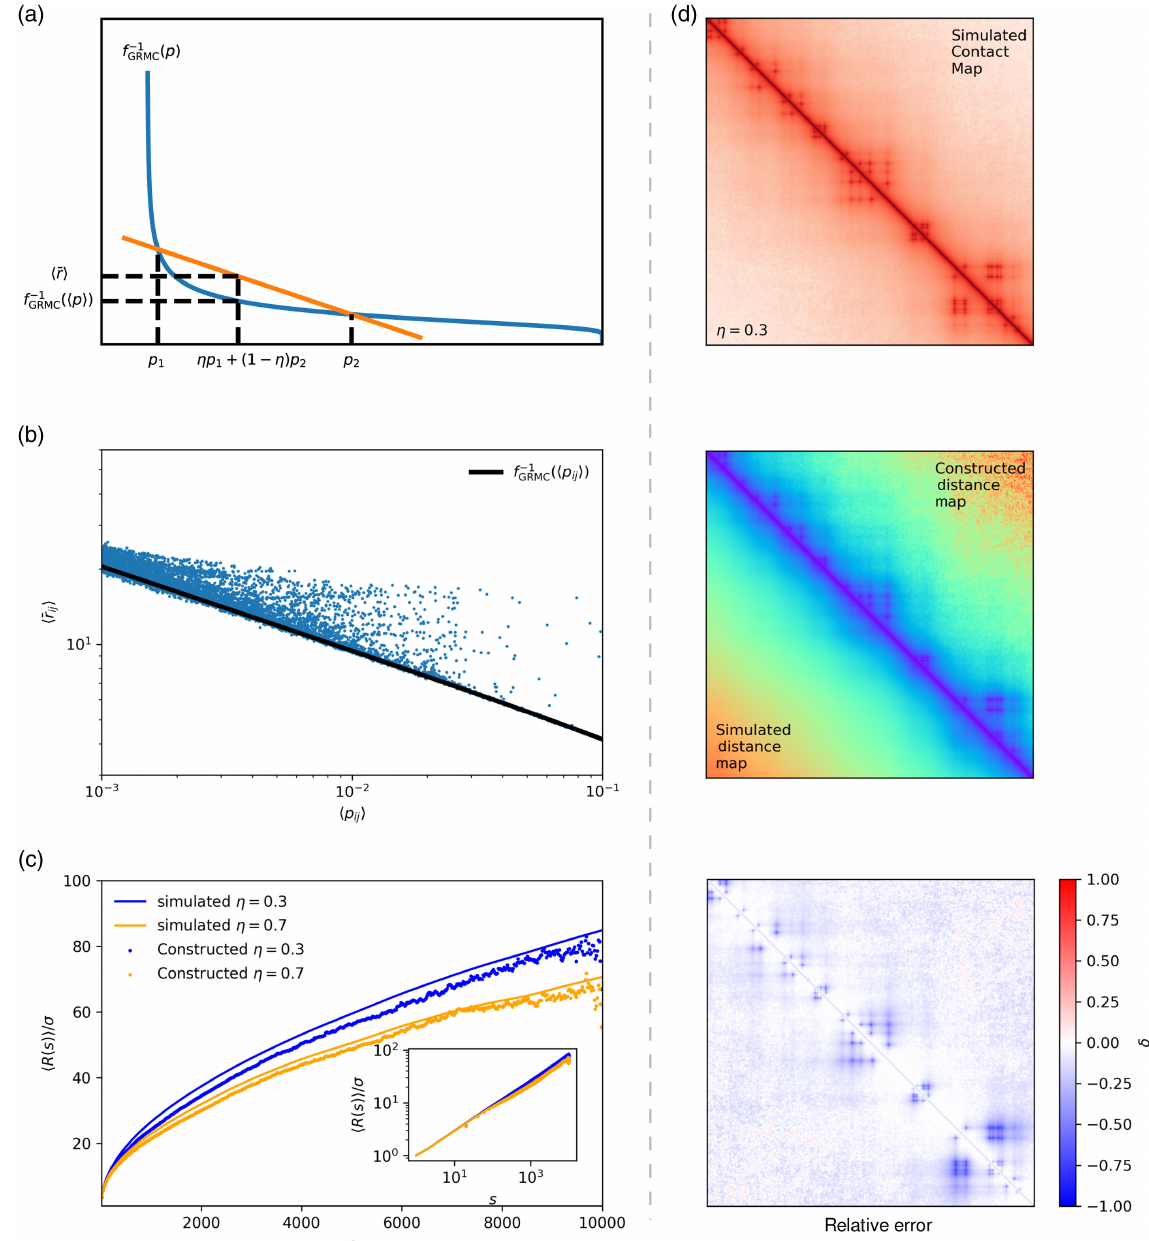
FIG. 2. (a) Lower bound for the mean spatial distance h ¯ r i illustrated graphically. The blue curve is the function f − 1 which exists GRMC since f is a monotonic function. The orange line is the secant line between the points [ p 1 ; f − 1 ð p 1 Þ ] and [ p 2 ; f − 1 ð p 2 Þ ]. All the GRMC GRMC GRMC points between p 1 and p 2 on the x axis can be expressed as η p 1 þ ð 1 − η Þ p 2 ≡ h p i for some value of η ∈ ½ 0 ; 1 (cid:2) . The y -axis value corresponding to h p i is η f − 1 ð p 1 Þ þ ð 1 − η Þ f − 1 ð p 2 Þ ≡ h ¯ r i and f − 1 ðh p iÞ for the orange line and blue curve, respectively. Note GRMC GRMC GRMC that for any values of p 1 , p 2 , and η , the orange line is always above the blue curve, which proves the inequality f − 1 ðh p iÞ ≤ h ¯ r i . From GRMC the graph, it can also be noted the equality holds only when p 1 ¼ p 2 . (b) Scatter plot for mean pairwise spatial distances versus the contact probabilities for η ¼ 0 . 3 . Solid black line is the theoretical lower bound, given by the solution f − 1 ðh p ij iÞ . (c) Plots of h R ð s Þi GRMC as a function of the genomic distance s , for η ¼ 0 . 3 and 0.7. The inset shows the same data on a log-log scale; h R ð s Þi is calculated using P P M T h R ð s Þi ¼ ð 1 =TM Þ ½ r ð a Þ ð t Þ δ ð s − j i − j jÞ = ð N − s Þ(cid:2) . The theoretical predictions are in excellent agreement with simulations. ij a ¼ 1 t ¼ 1 ¯ R ¯ R (d) Simulated h P i (top), simulated h i and inferred h i side by side (middle), and relative error map (bottom) for η ¼ 0 . 3 for GRMC. ¯ R Note that all the maps are block averaged from N ¼ 10 000 to size n ¼ 400 as explained in Appendix C. The inferred h i is obtained f − 1 using h ¯ r ðh p ij iÞ . Relative error map is shown with blue color indicating larger ij i ¼ GRMC